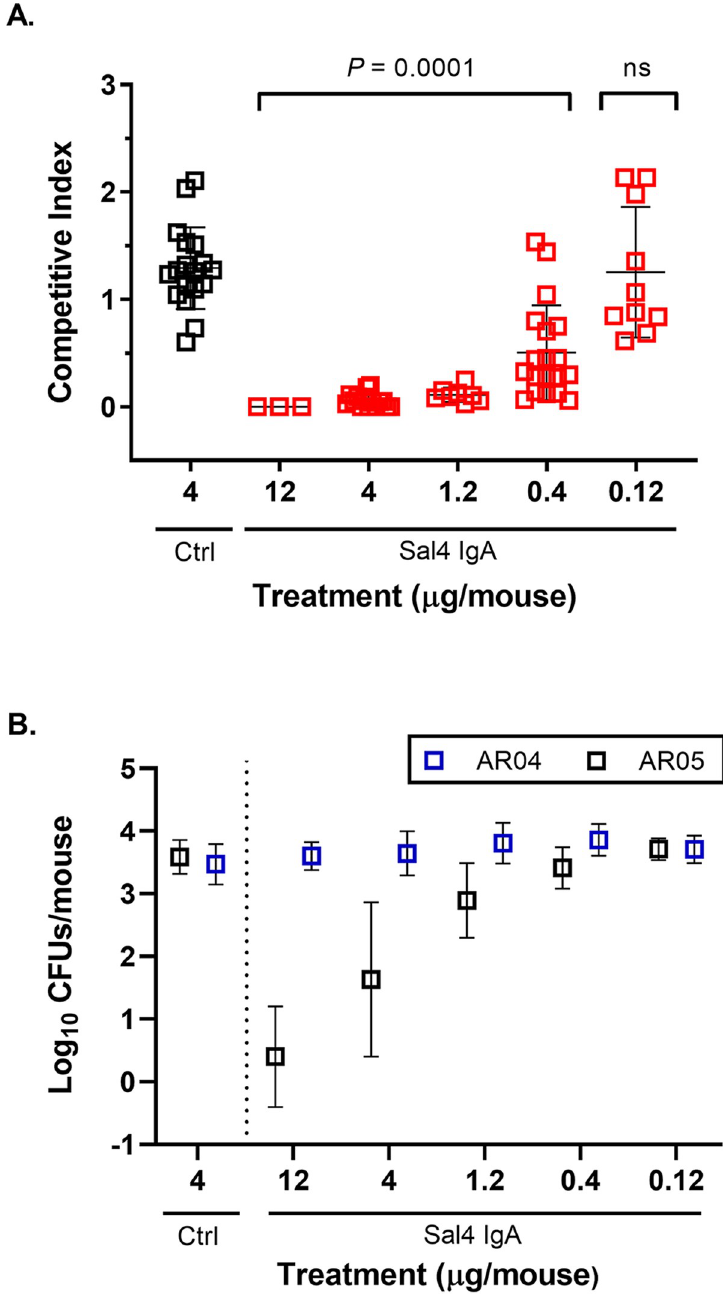
Fig 1. Orally administered Sal4 IgA blocks STm invasion into mouse Peyer’s patches. Adult BALB/c mice were challenged by gavage with a one-to-one mixture of STm O5 and O4 strains STm (4 x 10 7 CFU total) co-administered with Sal4 IgA or an isotype control. Peyer’s patches were collected ~24 h later and assessed for bacterial loads. (A) Competitive indices and (B) total CFUs of AR05 and AR04 STm. Shown are the combined results of five independent experiments with at least 4 mice per group. Each symbol represents an individual mouse. Statistical significance evaluated for each concentration over the isotype control, as determined by Kruskal-Wallis test and Dunn’s post-hoc